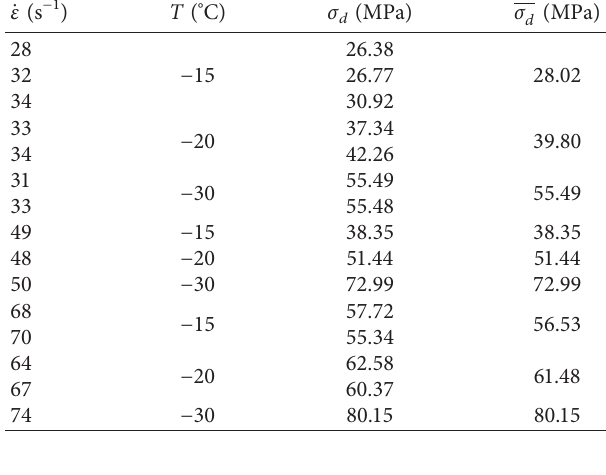
Table 5: Average peak stress of the frozen fine sandstone.